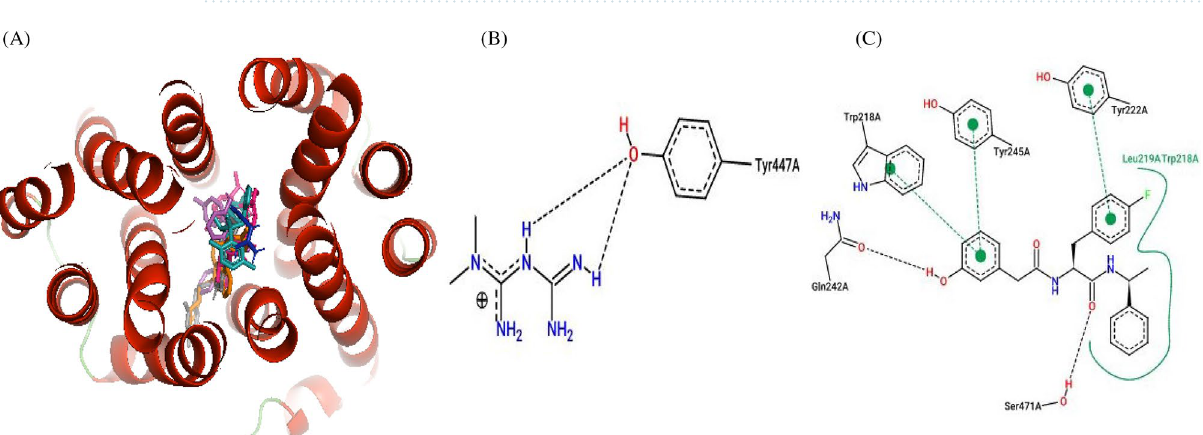
Figure 8. Ligand overlay for haplotype 3 SLC22A2 protein. ( A ) Image was generated using Pymol with the first line anti-diabetic drug, Metformin, shown in blue. The four top binding ligands Dolutegravir, Glibenclamide, Vandetanib and Isavuconazole are shown in grey, hot-pink, orange and deep teal respectively. The 5RE inhibitor is indicated in magenta. ( B,C ) 2D PoseView illustration, showing interacting residues for Metformin and the 5RE inhibitor respectively—dotted black lines denote hydrogen bonds, solid green lines denote hydrophobic interactions and dotted green lines denote π stacking &/or aromatic